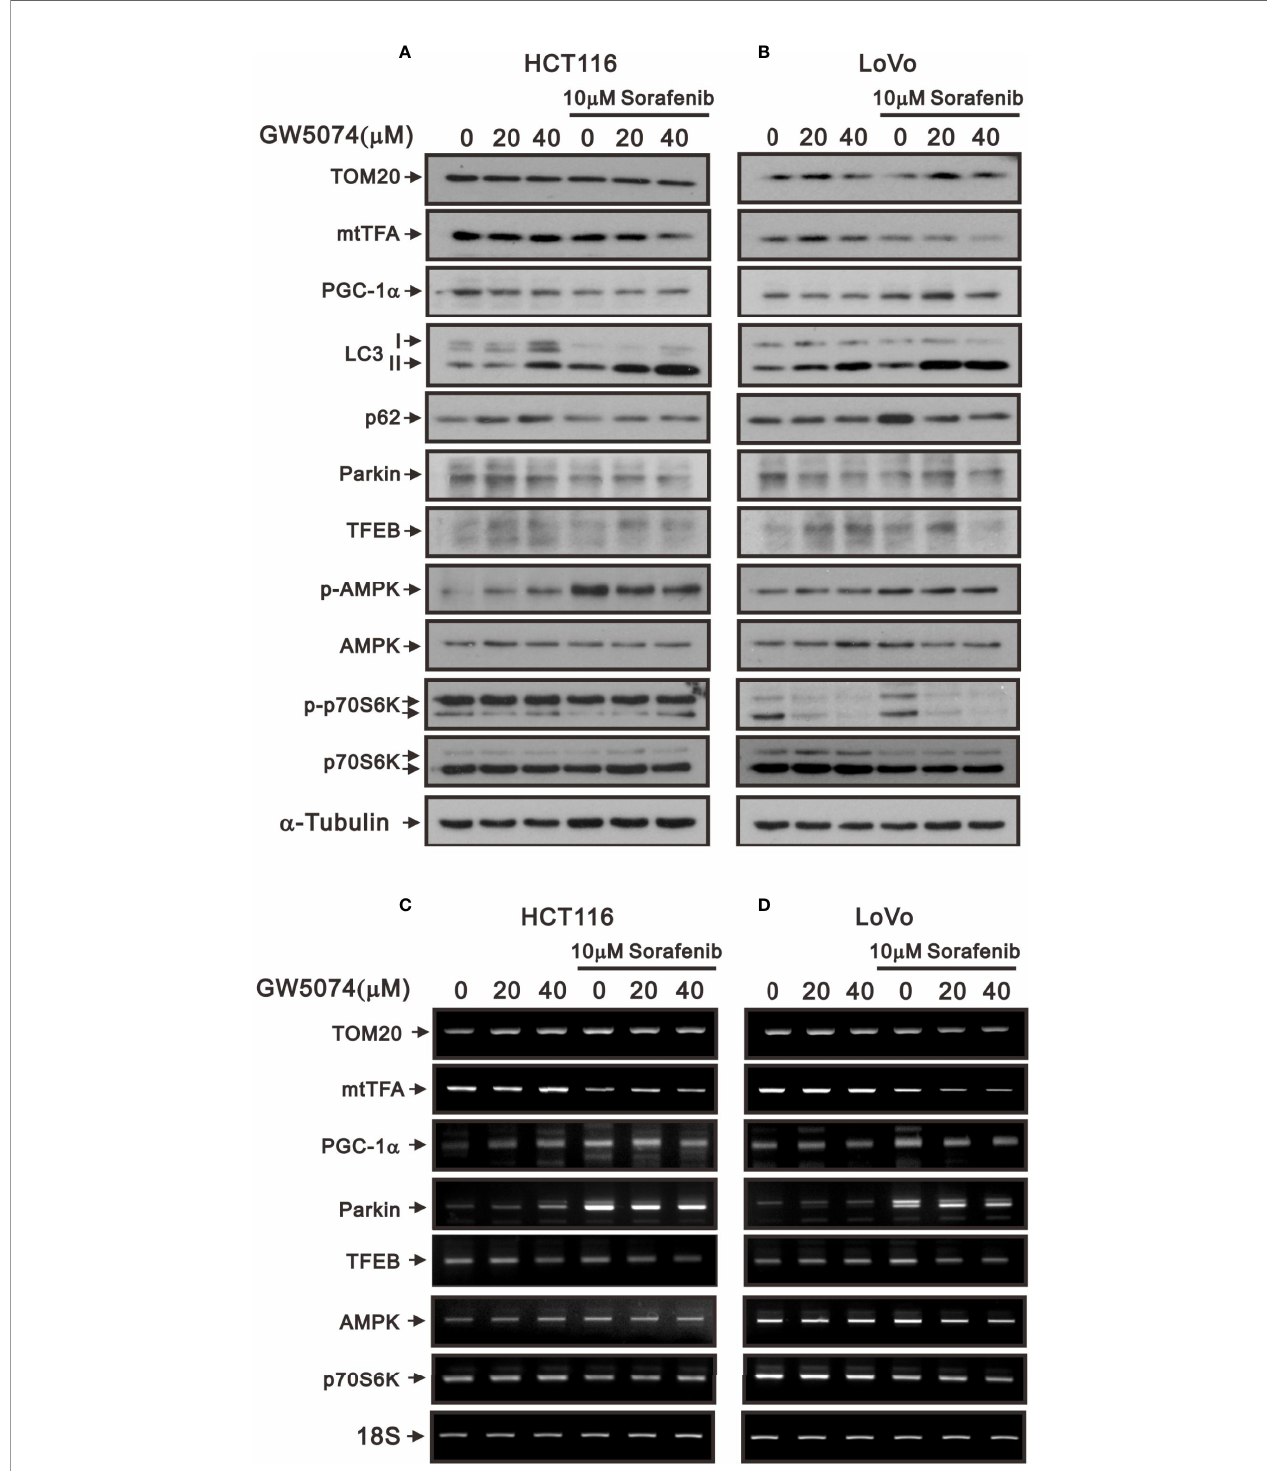
FIGURE 11 | The effects of GW5074 and sorafenib on the mitochondrial autophagy and biogenesis of HCT116 and LoVo cells. HCT116 and LoVo cells were treated with 0, 20, and 40 µM GW5074 in the absence or presence of 10 µM sorafenib for 24 h. (A, B) Cell lysates were subjected to Western blotting analysis. a -Tubulin is a loading control protein. (C, D) Total RNA were subjected to RT-PCR analysis. 18S is a loading